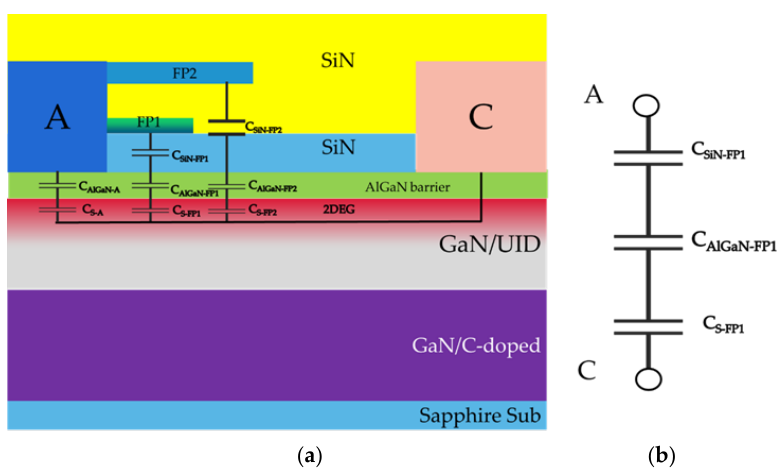
Figure 5. ( a ) Parasitic capacitance model of device. ( b ) Equivalent circuit model.